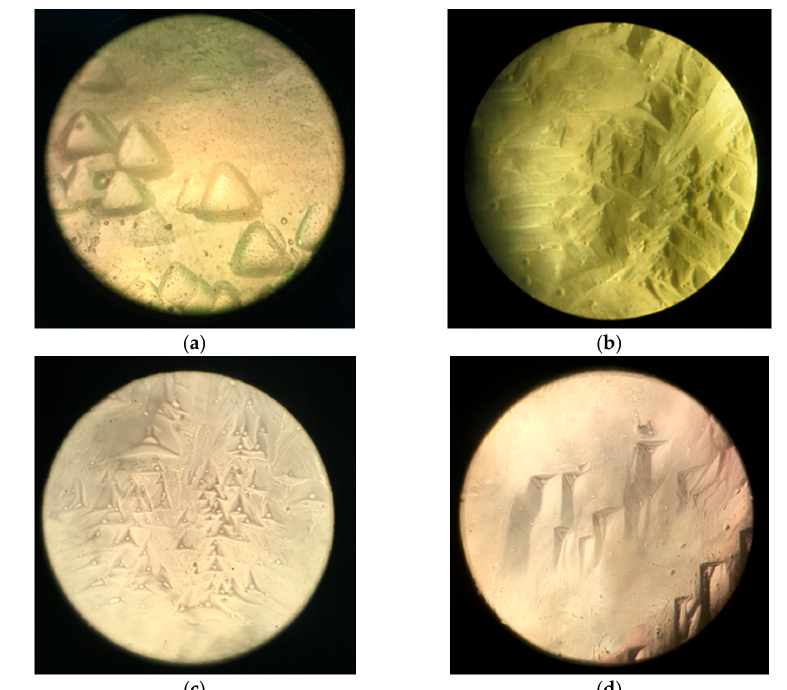
Figure 5. Dislocation etch pits for ( a ) (I), ( b )(II), ( c ) (III), and ( d ) (IV).